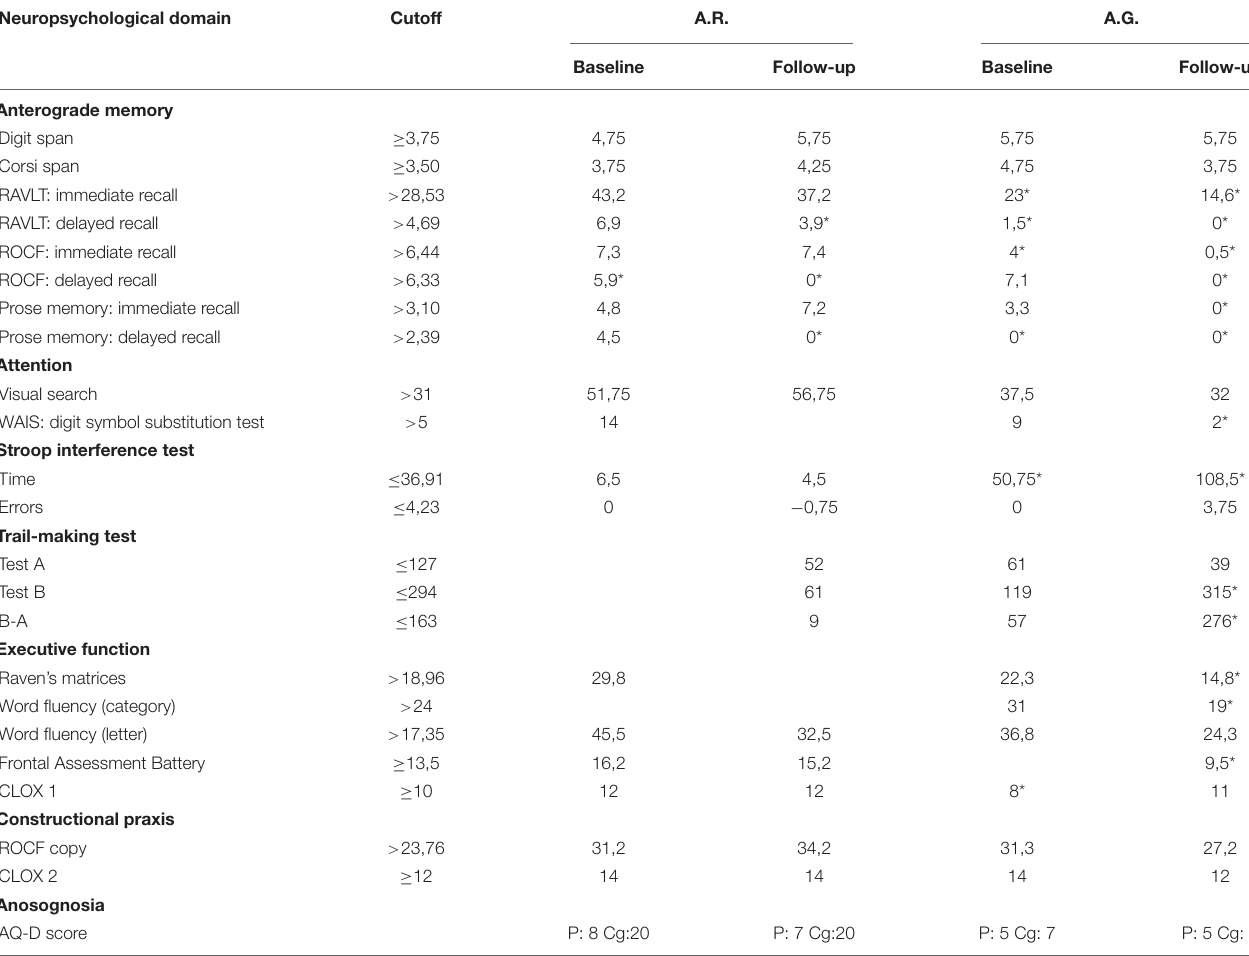
TABLE 1 | Results of neuropsychological evaluation performed at baseline and during a follow-up visit. Neuropsychological domain